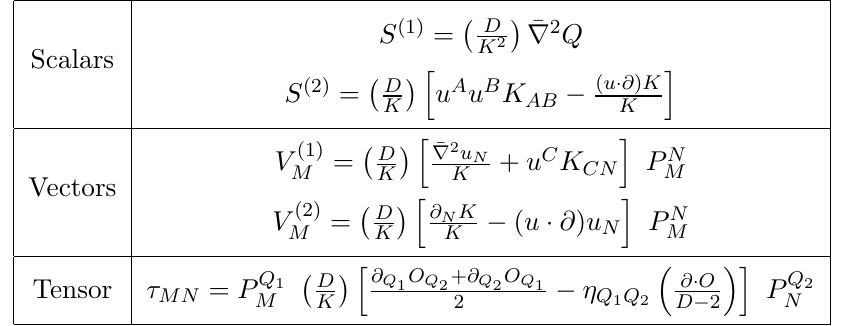
Table 1 . A listing of the ‘(cid:12)rst order’ quantities that appear in the formula for the metric and gauge (cid:12)eld, taken from